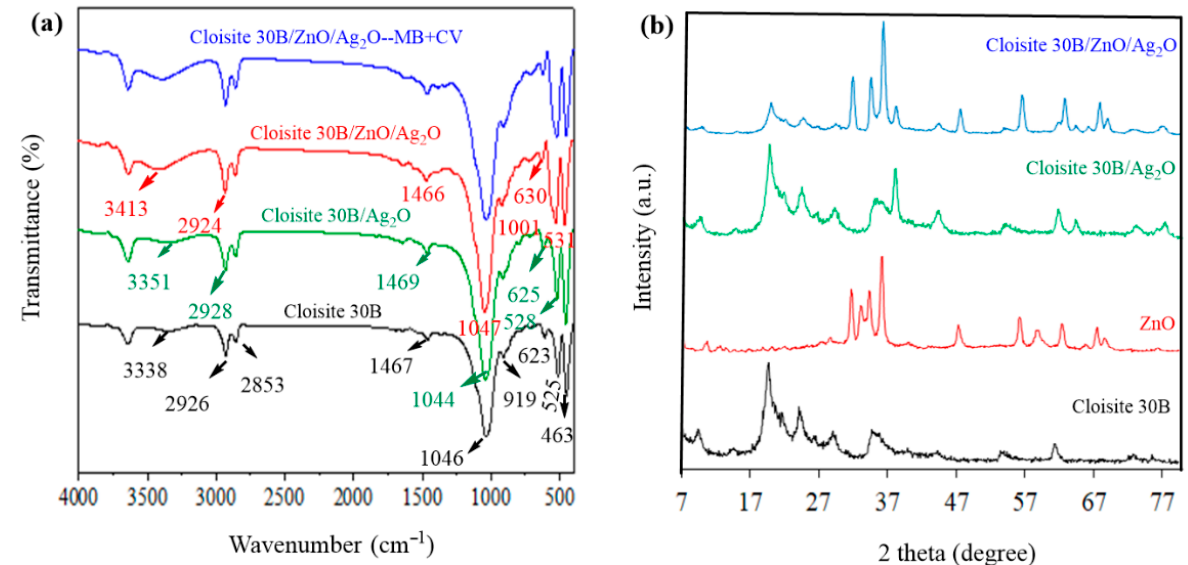
Figure 2. ( a ) FTIR analysis for Cloisite 30B, Cloisite 30B/Ag 2 O, and Cloisite 30B/ZnO/Ag 2 O samples before and after the simultaneous catalytic removal process of dyes and ( b ) XRD analysis for Cloisite 30B, ZnO, Cloisite 30B/Ag 2 O and Cloisite 30B/ZnO/Ag 2 O. In Figure 2b, XRD spectra for Cloisite 30B, ZnO, Cloisite 30B/Ag 2 O and Cloisite 30B/ZnO/Ag 2 O samples are presented. In the structure of Cloisite 30B, a peak is observed in the range of 2 θ equal to 7.34 o , which corresponds to the interlayer distance of 7.6 Å, where, after modification of Cloisite 30B using Ag 2 O and Ag 2 O/ZnO, the range of this peak and the distance between the layers increased. The increase in the interlayer distance after modification shows that the layers in the Cloisite 30B structure are well exfoliated [41] and the desired metal oxides are well placed in the Cloisite 30B layers. In addition, in the structure of Cloisite 30B, peaks with different intensities appeared in the range of 17–80 ◦ , and these peaks can be caused by the quartz present in the sample structure and show that Cloisite 30B has a crystalline structure [42]. In the structure of ZnO in the range of 7–80 ◦ , peaks with different intensity and sizes have appeared, which indicate crystal planes (100), (002), (101), (102), (110), (103) and (112) that exist in the ZnO structure [43]. After modification of Cloisite 30B using Ag 2 O nanoparticles, peaks in the range of 37.39,